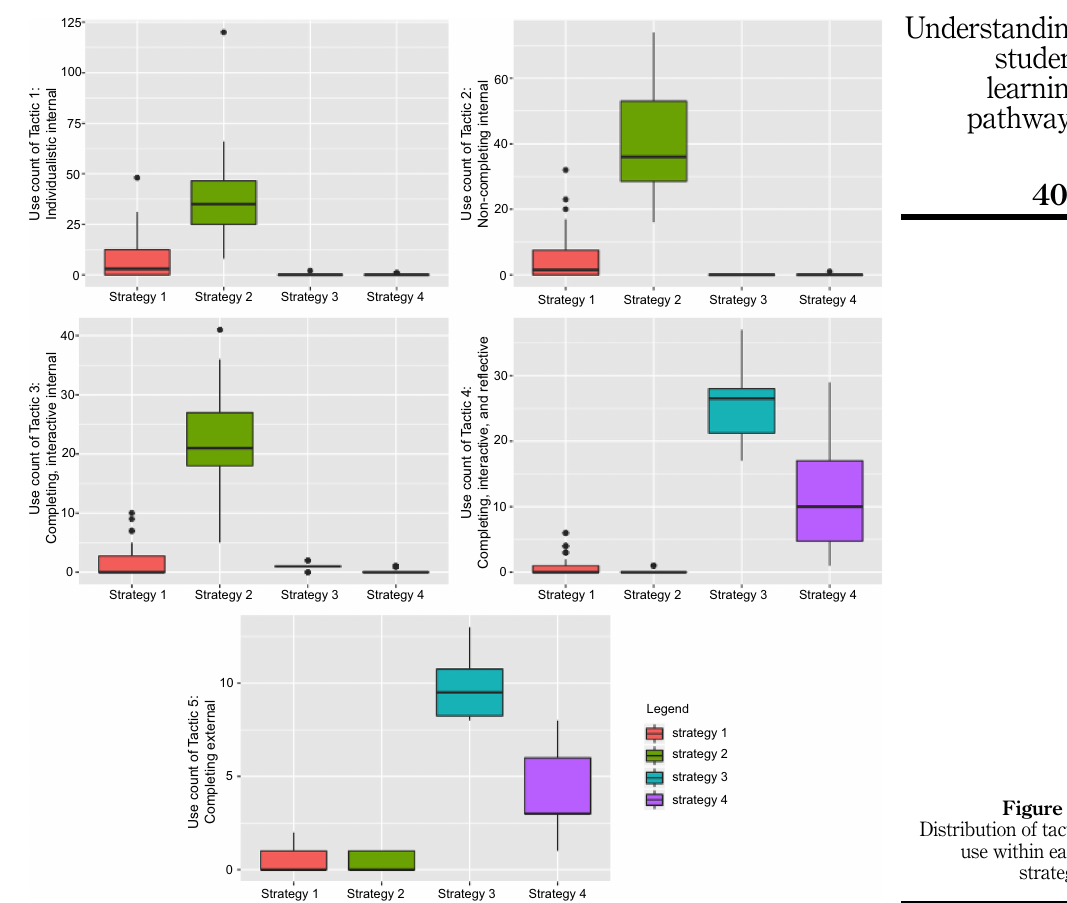
Figure 2. Distribution of tactic use within each